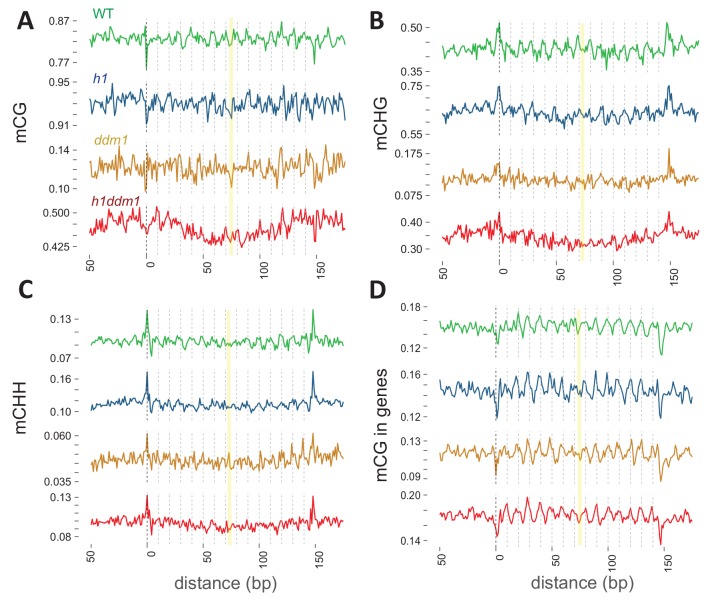
DDM1 is required for 10 bp methylation periodicity at heterochromatic nucleosomes.Average DNA methylation in the indicated contexts across 147 bp MNase-seq fragments in heterochromatic TEs (A–C) and genes (D) for WT (green), h1 (blue), ddm1 (orange), and h1ddm1 (red). Yellow line indicates the approximate position of the presumptive dyad, where the DNA major groove faces nucleosomal histones.